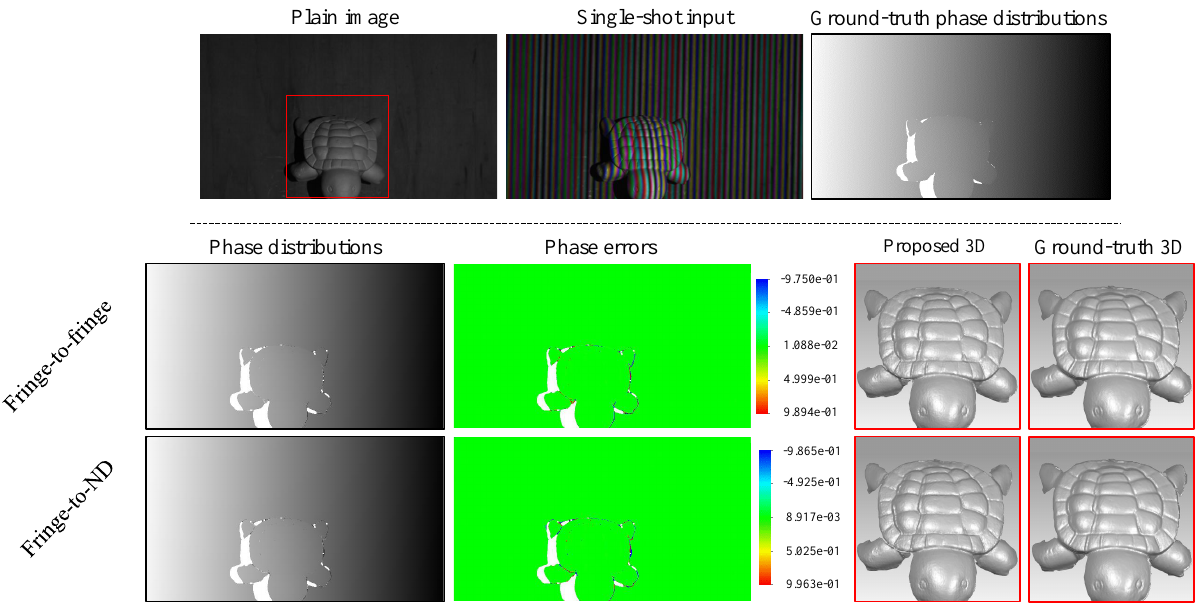
Figure 7. Phase distributions, phase errors, and 3D shape reconstruction of the proposed fringe-to-fringe technique and the competitive fringe-to-ND